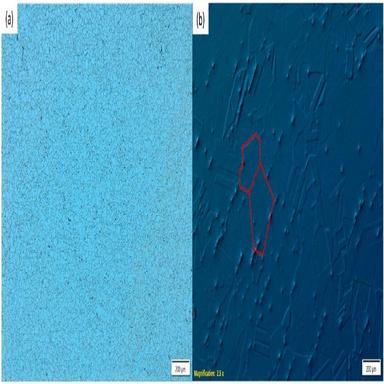
Optical images of samples (a) as received and (b) after heat damage (with grains outlined in red for clarity). The delta phase can be seen before heat damage as the black 'needles' delineating the grains, and are absent after heat damage has occurred. The γ′ and γ'' phases are beyond the resolution of the microscope. (For interpretation of the references to colour in this figure legend, the reader is referred to the Web version of this article.)